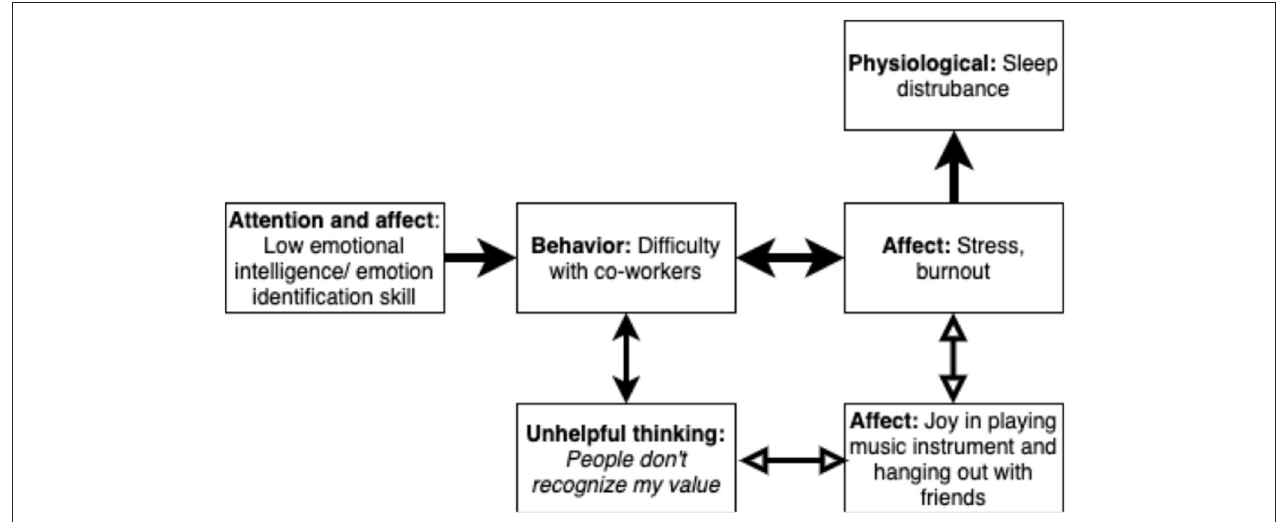
FIGURE 2 | Positive and negative processes as distinct and interacting. Note: Clear arrows indicate negative relationships. Width of line indicates strength of